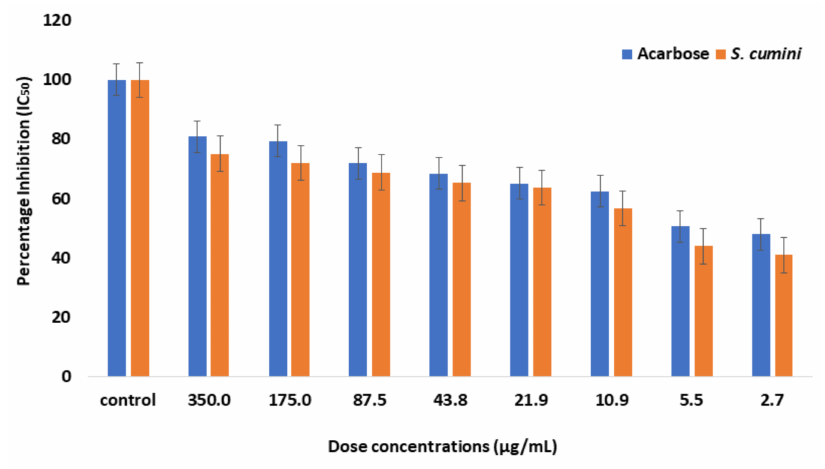
Figure 1. The percentage inhibition of α -glucosidase by increasing concentrations of acarbose and S. cumini extract. The resulting IC 50 is 8.07 ( µ g/mL) for S. cumini . This data was taken in triplicates (n = 3) with SD ± mean values.